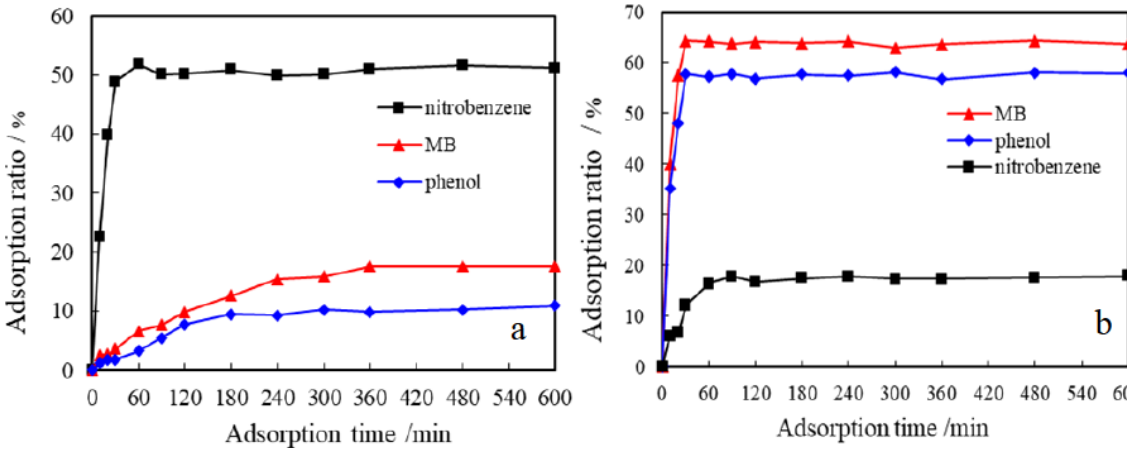
Figure 5: Adsorption curves of nitrobenzene, phenol and MB by SiO 2 (AG) Table 2: Isothermal adsorption fitting results of nitrobenzene, phenol and MB by SiO 2 (AG) adsorbent adsorbate Langmuir